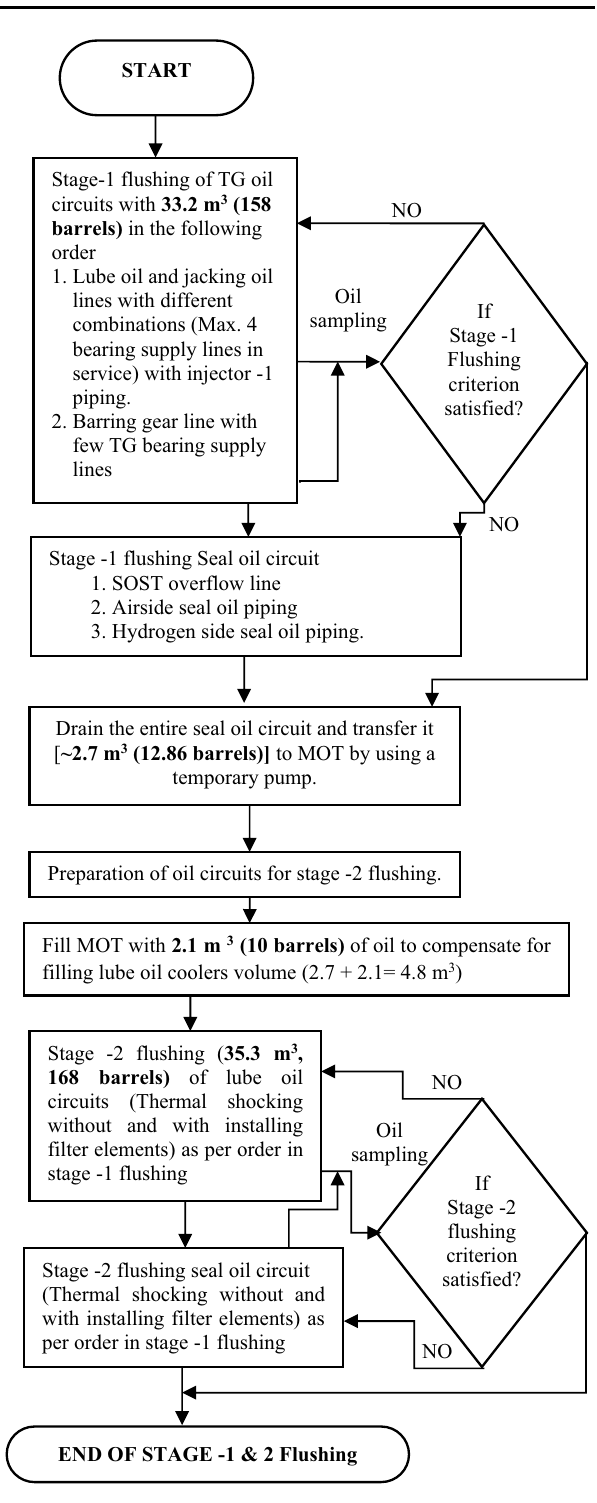
Fig. 7 Optimum oil flushing methodology for stage-1 and stage-2